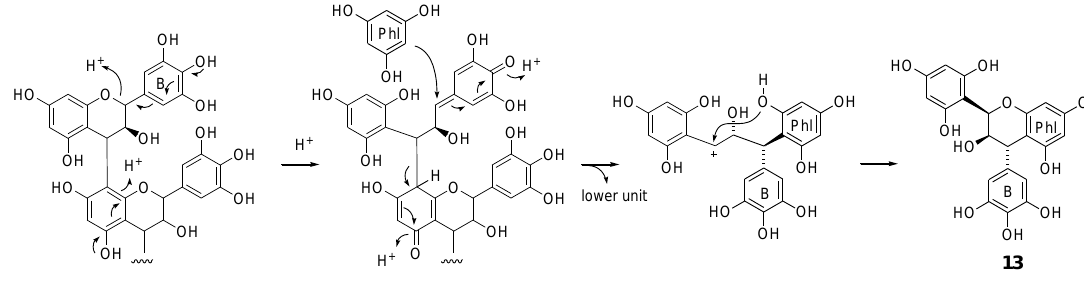
Scheme 2. A possible production mechanism of 13 .